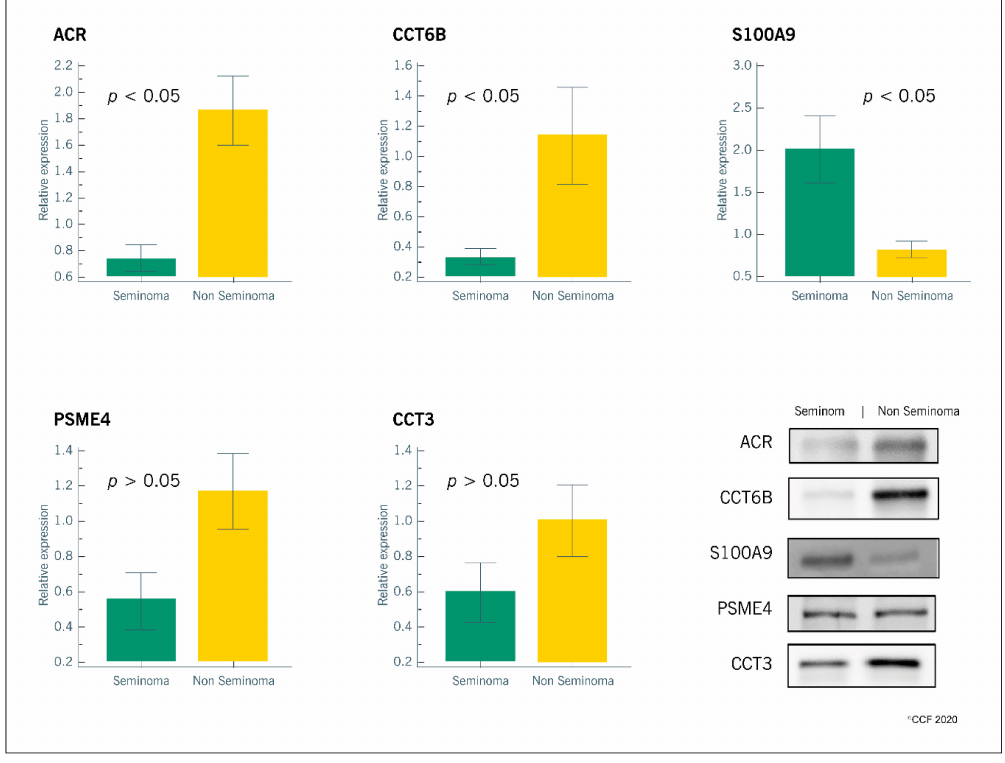
Figure 2. Graphical representation of the expression levels of proteins involved in reproductive functions (ACR, CCT6B, S100A9, PSME4 and CCT3) in spermatozoa samples obtained from patients with seminomatous ( n = 6) or non-seminomatous ( n = 6) testicular germ cell tumors. Results are presented as relative expression (mean ± SEM). Significantly di ff erent results between the two groups are indicated as p < 0.05. Representative blots for each protein are also